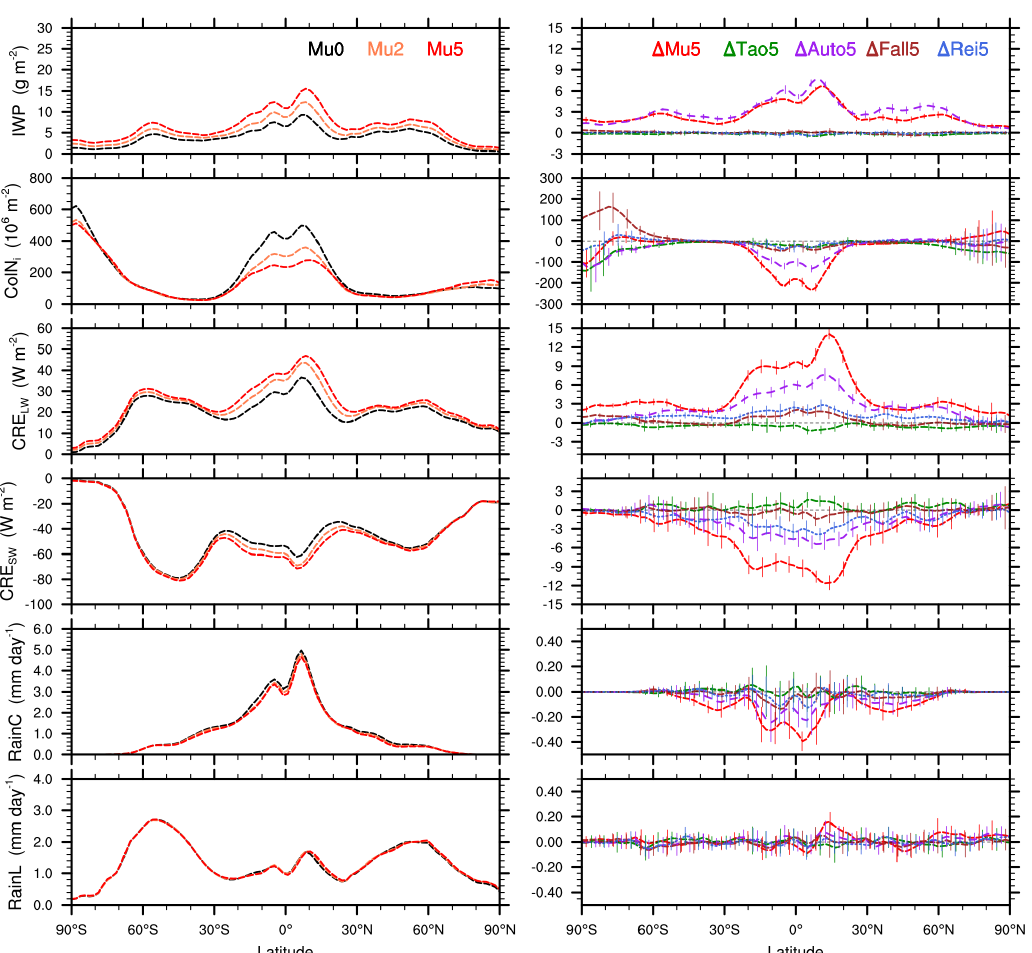
Figure 4. Annual zonal mean distributions of the ice water path (IWP), column N i (ColN i ), longwave and shortwave cloud radiative effects (CRE LW and CRE SW ), and convective and large-scale precipitation rates (RainC and RainL). In the right panel (i.e., (cid:49) ), the vertical bars overlying these lines indicate the ranges of 2 standard deviations from the difference of each of 10 years at different